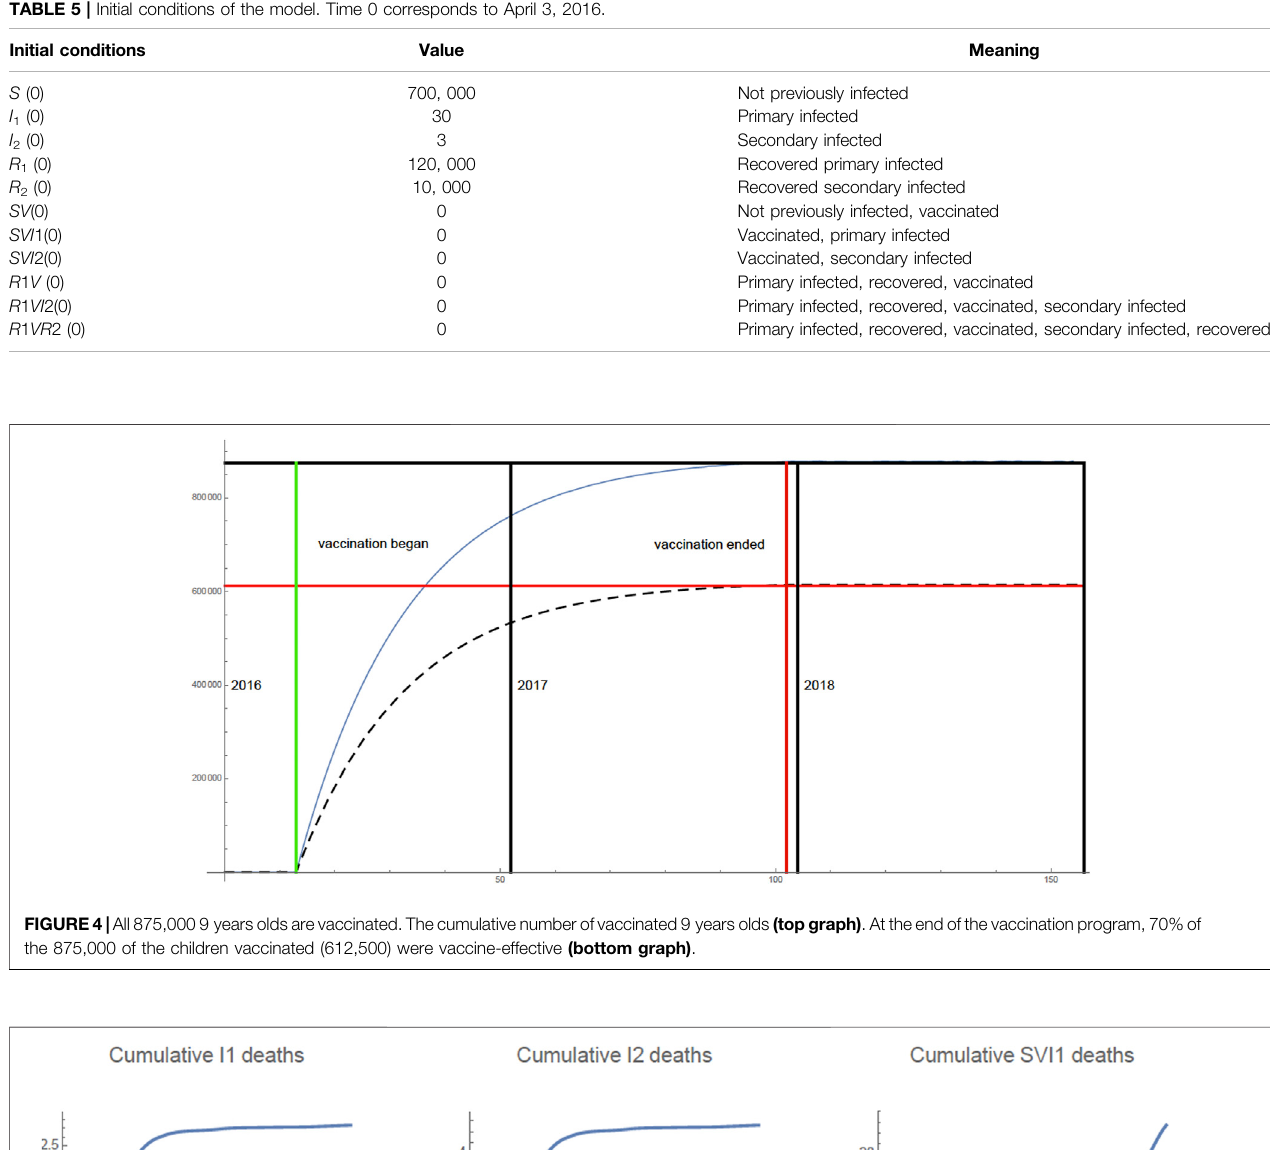
the compartments I 1 ( t ), I 2 ( t ), SVI 1 ( t ). The cumulative number of deaths in the compartments SVI 2 and R 1 VI 2 are negligible.